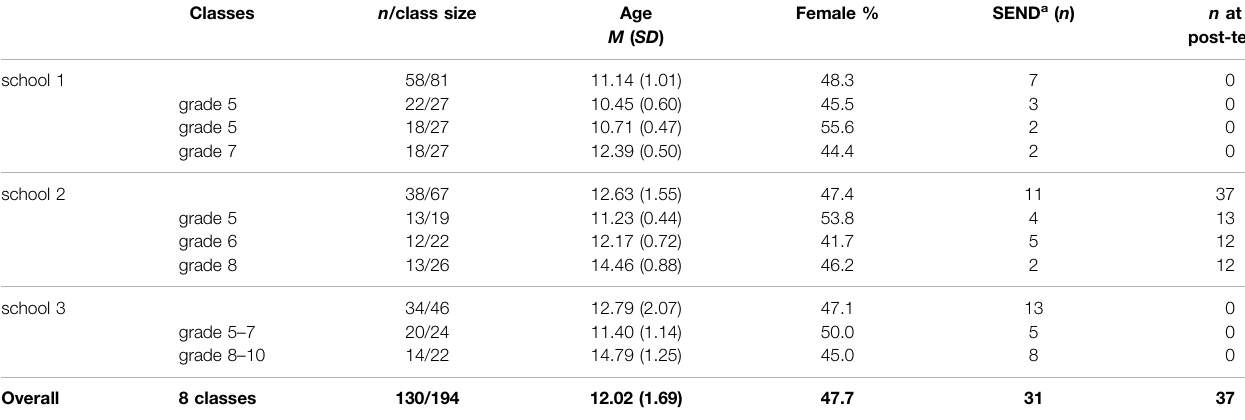
TABLE 1 | Demographic information of participants in Study